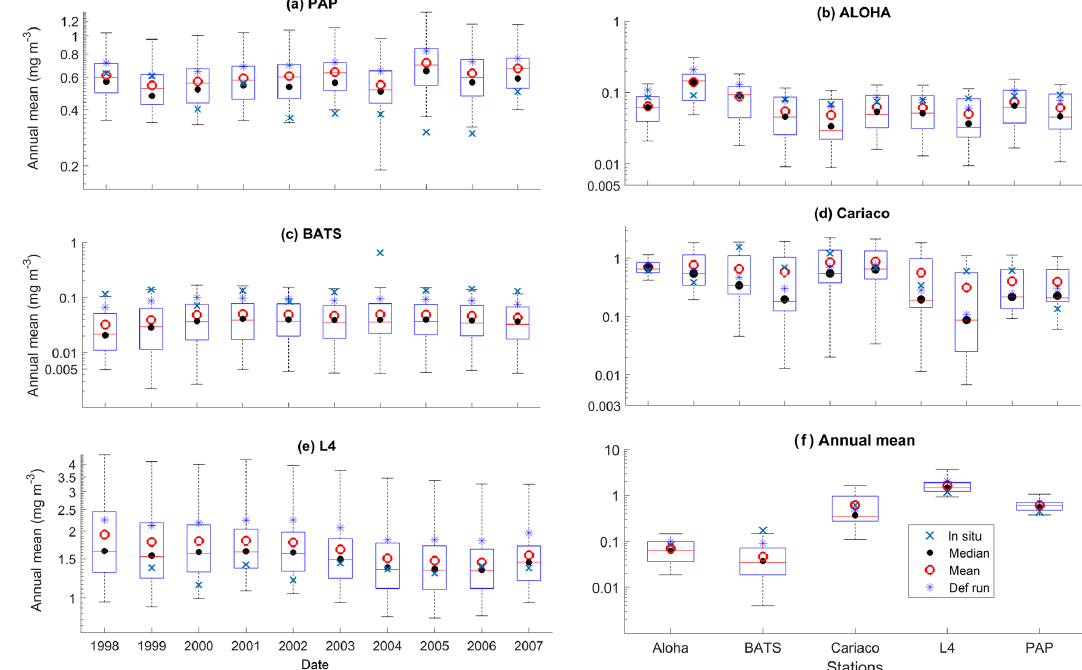
Figure 4. Inter-annual mean of surface chlorophyll from all the study sites ( a – e ) and the 10-year annual mean (f) , all measured in mgm − 3 . The box plots show the ensemble annual means. The blue cross is the in situ observation; the red open circle, black dot, and blue stars are the ensemble mean, median, and the default run respectively. The blue box is the 75th and 25th quartiles. The red line is the median. The whiskers are the ensemble minimum and maximum mean of surface chlorophyll. Annual mean values and NRR are described in Table